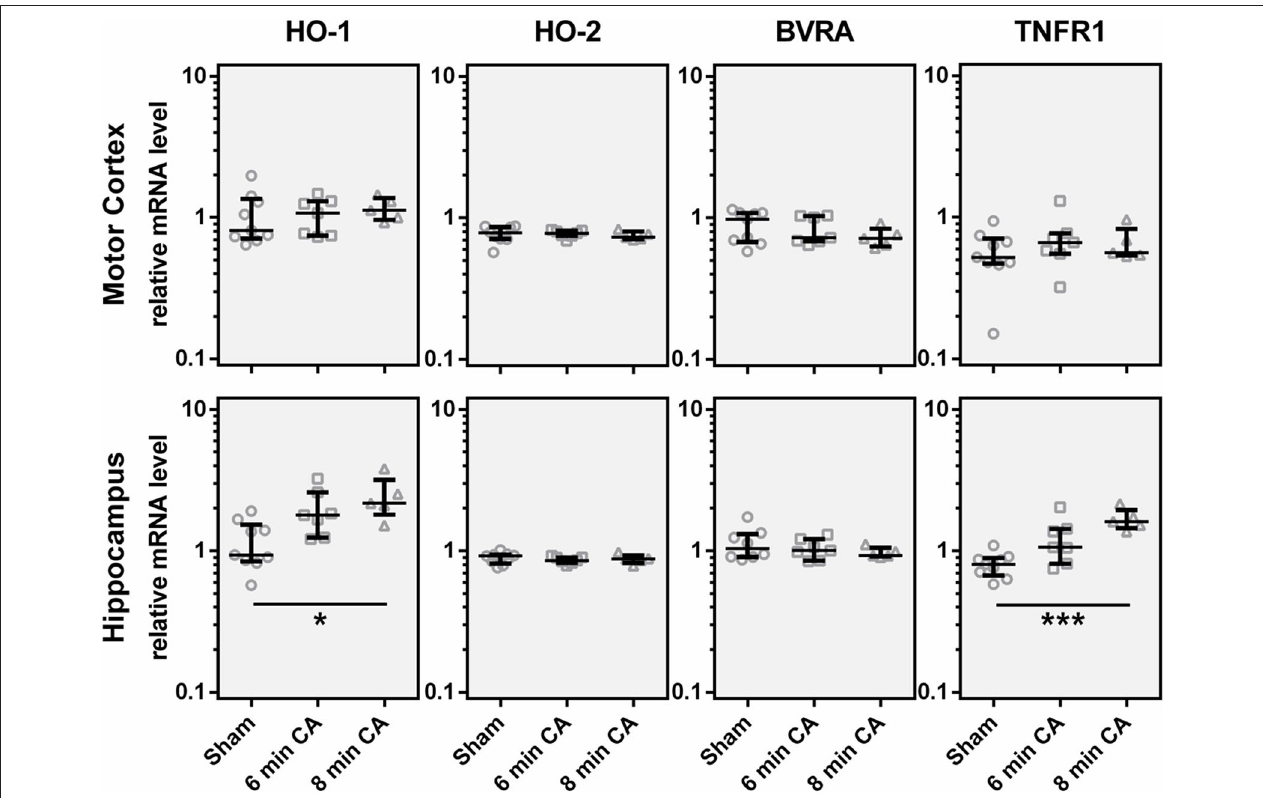
FIGURE 6 | Expression of, HO-1, HO-2, BVRA and TNFR1 mRNA in motor cortex and hippocampus 2 weeks following cardiac arrest (CA). Gene expression was quantified by qPCR. Data were normalized against the internal reference genes HPRT and Cyclophilin A and expressed relative to the IS (relative mRNA level). Gene expression levels are shown for single animals (gray open symbols) in each group: sham animals (open circles, n = 9), rats subjected to CA for 6min (CA 6min, open squares, n = 7) or 8min (CA 8min, open triangles, n = 6), indicating additionally group medians (thin black line) and 1st and 3rd quartiles (bold black lines). Significant differences between groups were calculated by one-way non-parametric ANOVA (Kruskal Wallis followed by Bonferroni-correction) and are indicated (* p < 0.05; *** p < 0.005).